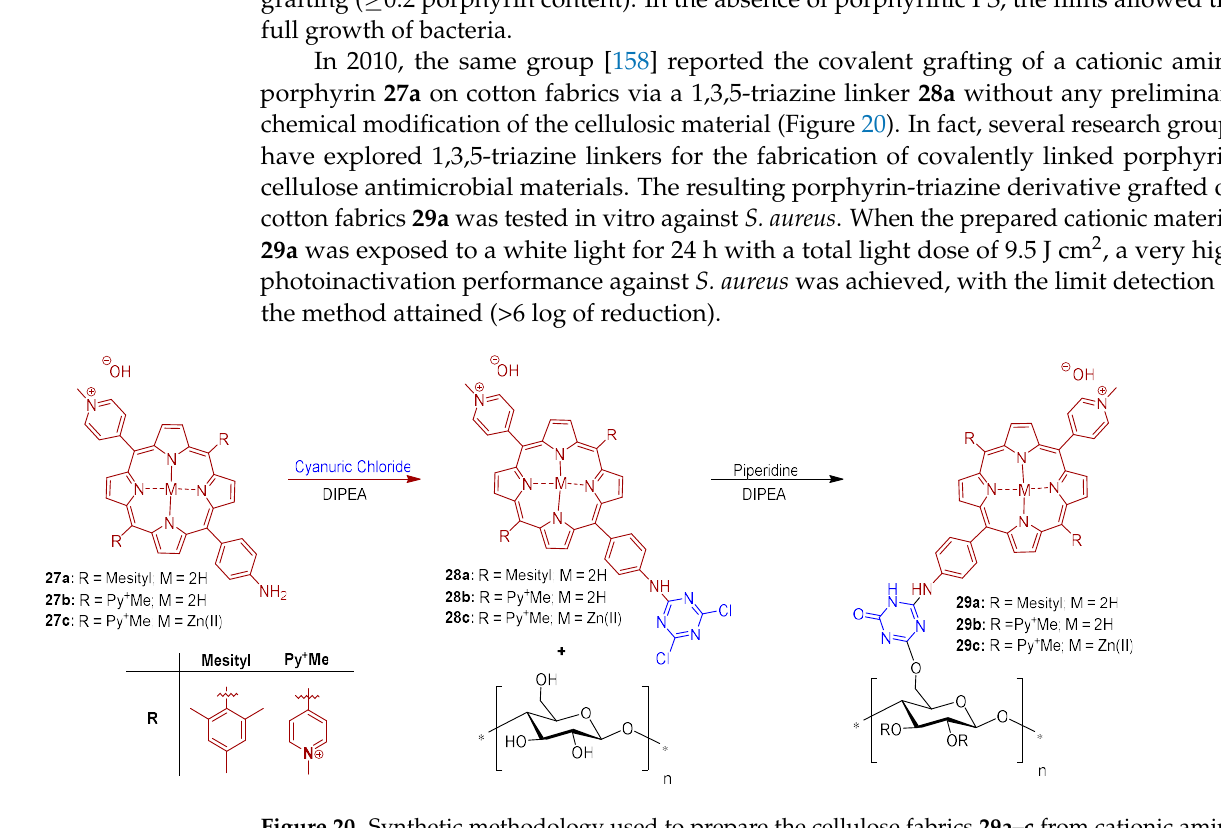
Figure 20. Synthetic methodology used to prepare the cellulose fabrics 29a – c from cationic amino porphyrins using cyanuric chloride to introduce the grafting unit (Adapted from references [158,166]). bacterial strain E. coli [166]. After 24 h of exposure to white light (a total light dose